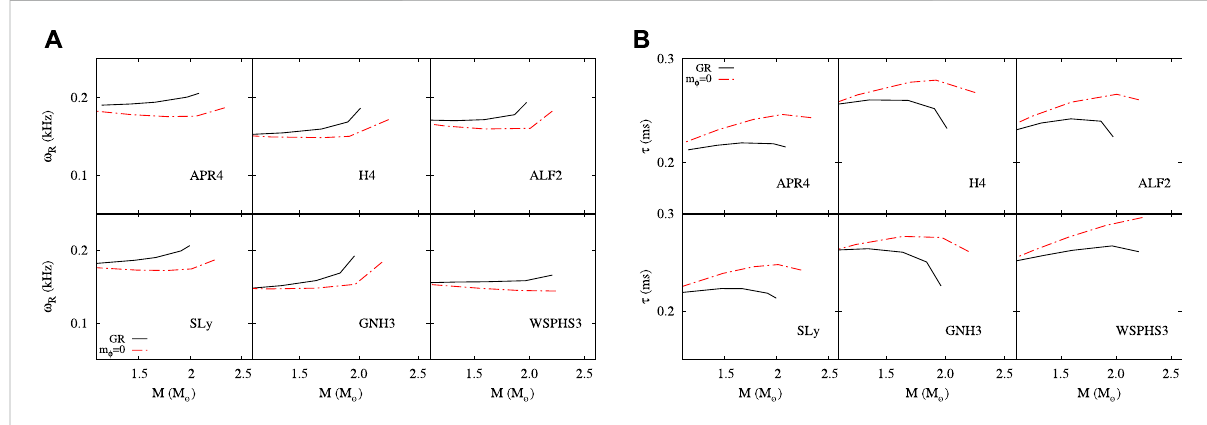
FIGURE 11 Frequency ω R in kHz (A) and damping time τ in milliseconds (B) versus the neutron star mass M in M ⊙ for the radial ϕ -mode. The six panels represent six equations of state, and the color red indicates the massless case, with the general relativistic case in black.